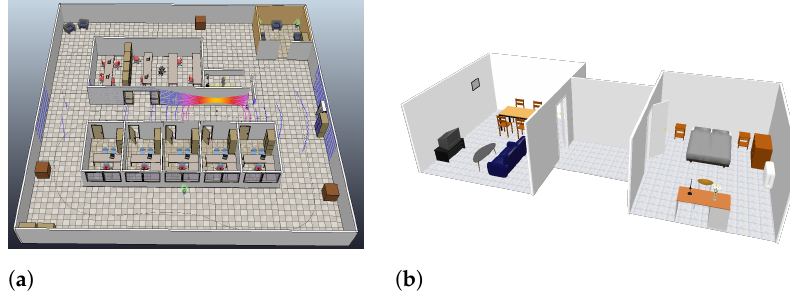
Figure 5. Proposed virtual scenarios. ( a ) 2D/3D SLAM. ( b ) Geometric Segmentation.